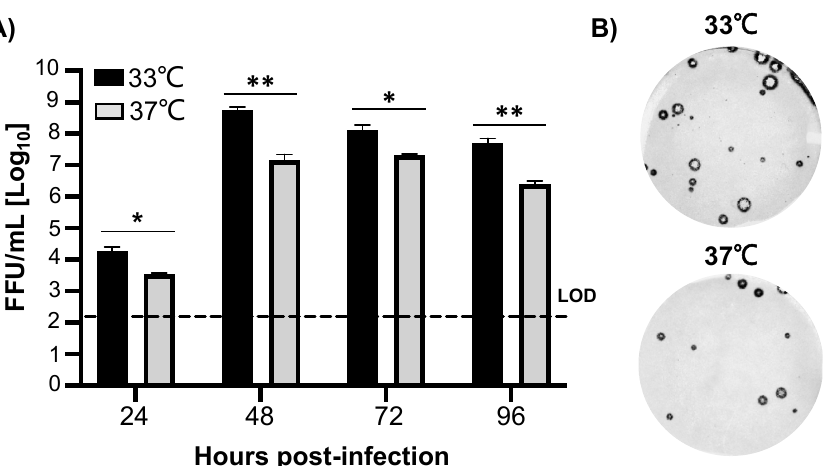
Figure 2. Influenza B/Brisbane/60/2008 WT replication at different temperatures. ( A ) Viral growth kinetics: Confluent monolayers of MDCK cells were infected (MOI 0.01 FFU/cell) with B/Brisbane/60/2008 WT. After 1 h infection cells were incubated at 33 ◦ C (black) or 37 ◦ C (gray). Tissue culture supernatants were collected at 24, 48, 72 and 96 h post-infection. Viral titrations were determined using an immunofocus assay (fluorescent forming units, FFU/mL) with a mouse monoclonal antibody against IBV NP. Data is represented as the mean and SD. Dotted line indicates the limit of detection (LOD) of the assay (200 FFU). Student t test was performed to determine p values. *, p < 0.05; **, p < 0.01. ( B ) Plaque assays: Confluent monolayers of MDCK cells were infected with B/Brisbane/60/2008 WT. After 1 h infection, cells were overlaid with media containing agar and incubated at 33 ° C (top) or 37 ° C (bottom). At 72 h post-infection viral plaques were immunostained with an anti-IBV NP mouse monoclonal antibody.